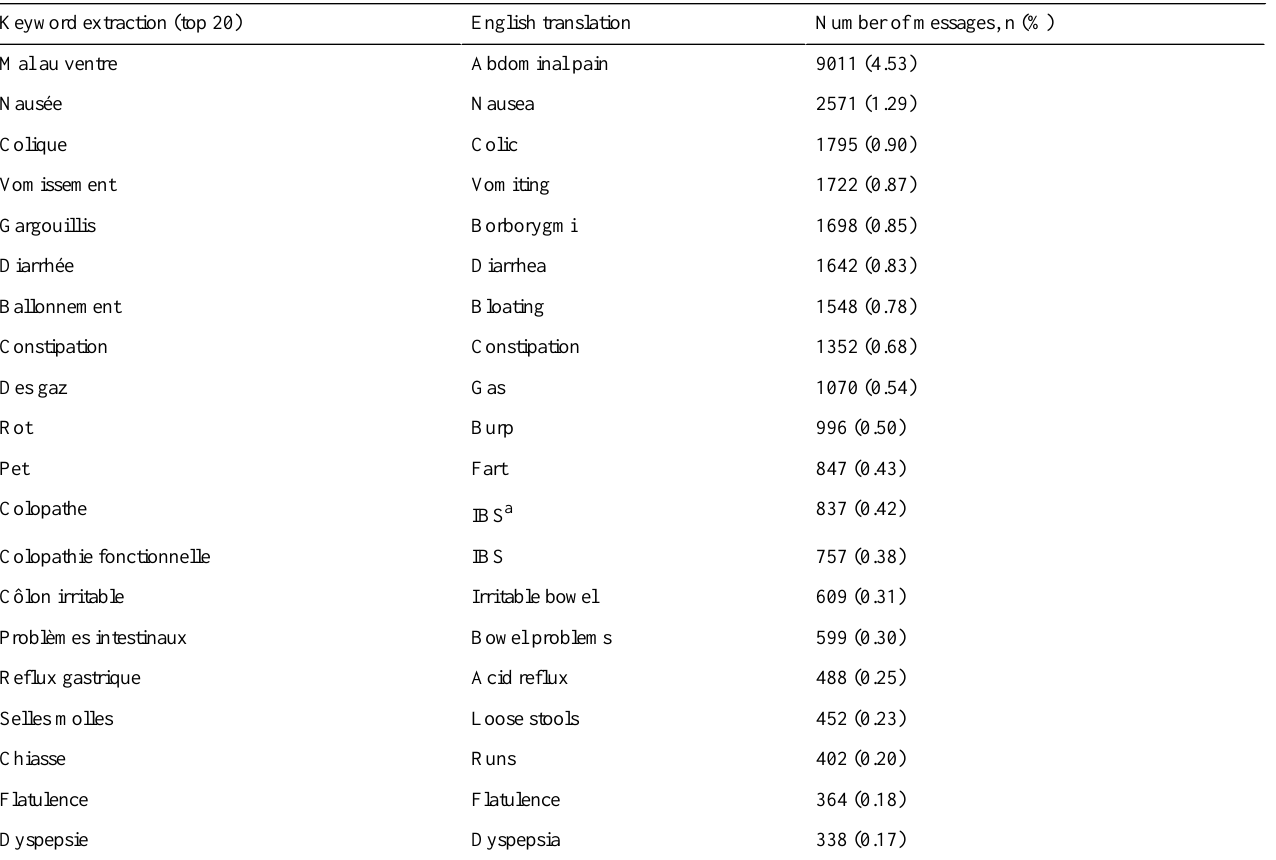
Table 1. Most frequently used extraction